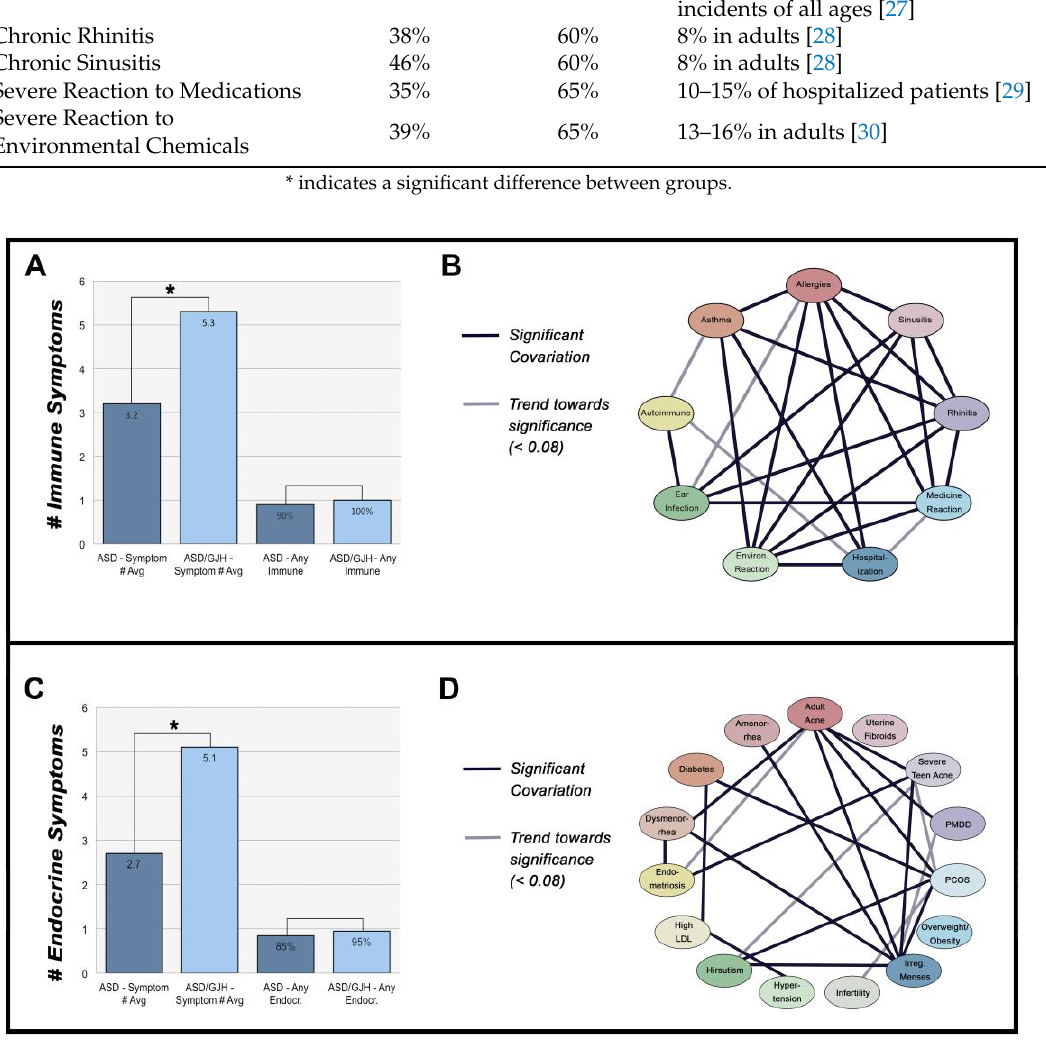
Figure 2. ( A ) Number of immune-mediated symptoms across ASD and ASD/GJH groups. ‘Any immune’ = 1 or more immune symptoms. ( B ) Network of immune-mediated symptoms. ( C ) Number of endocrine-mediates symptoms across ASD and ASD/GJH groups. ‘Any endocr.’ = 1 or more endocrine symptoms. ( D ) Network of endocrine-mediated symptoms.